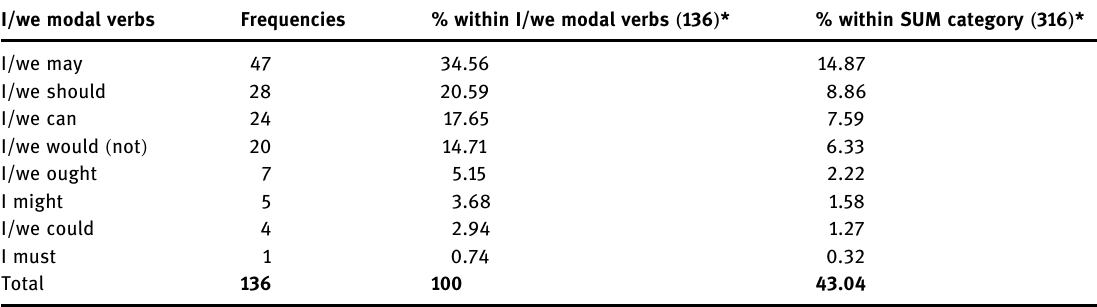
Table 6: Frequencies and percentages of I/we modal verbs in the whole corpus I/we modal